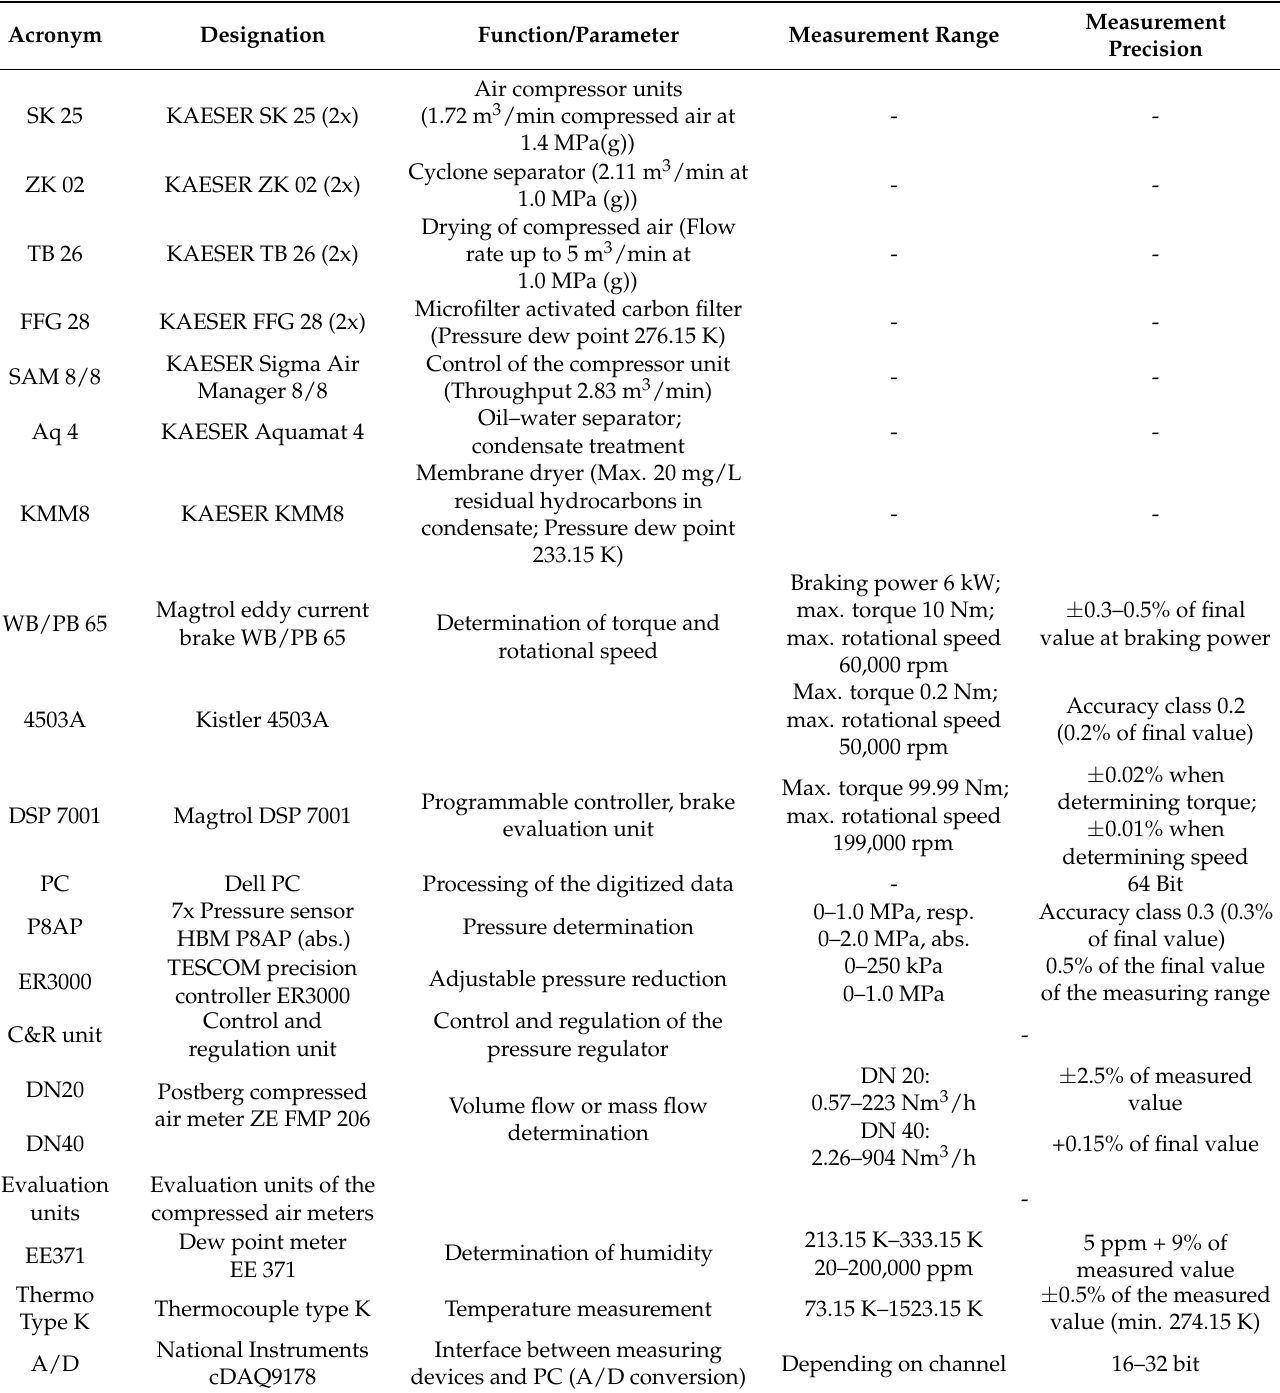
Table 3. Components of the PDLT